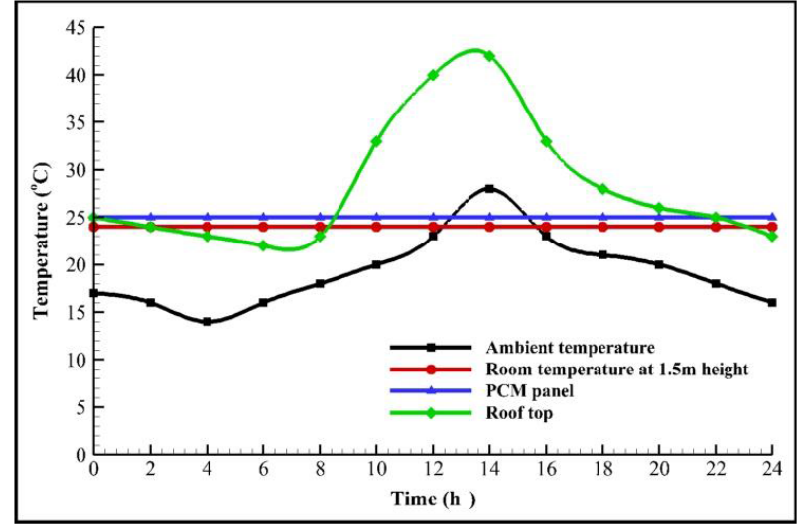
Figure 6. Temperature variation of the test room with and without PCM (REF) at a height of 1.5 m in the month of January.